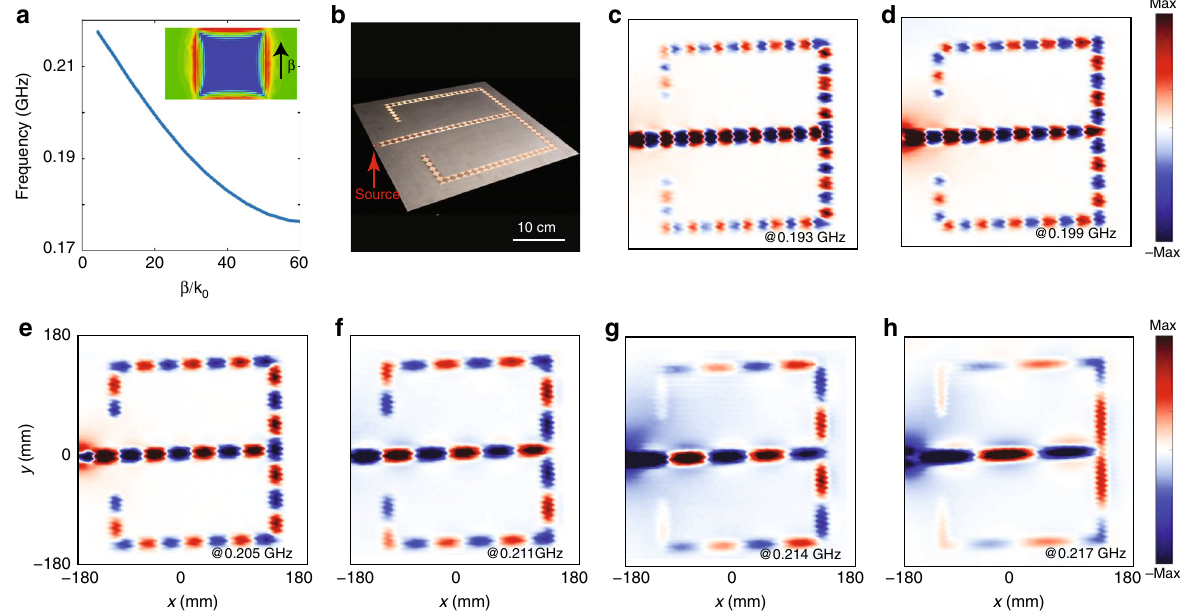
Fig. 5 A deep sub-wavelength integrated waveguide circuit based on the type-I hyperbolic metasurface. a Dispersion of the meta-ribbon. b A fabricated sample of the deep-sub-wavelength waveguide circuit. The red arrow represents the source location. c – h Measured H z fi eld distributions on the plane 5 mm over the metasurface at 0.193 GHz ( c ), 0.199 GHz ( d ), 0.205GHz ( e ), 0.211 GHz ( f ), 0.211 GHz ( g ), and 0.217 GHz ( h ), respectively. Here, the whole measured region is below the diffraction limit, i.e., half of the free-space wavelength NATURE COMMUNICATIONS| (2019) 10:2002